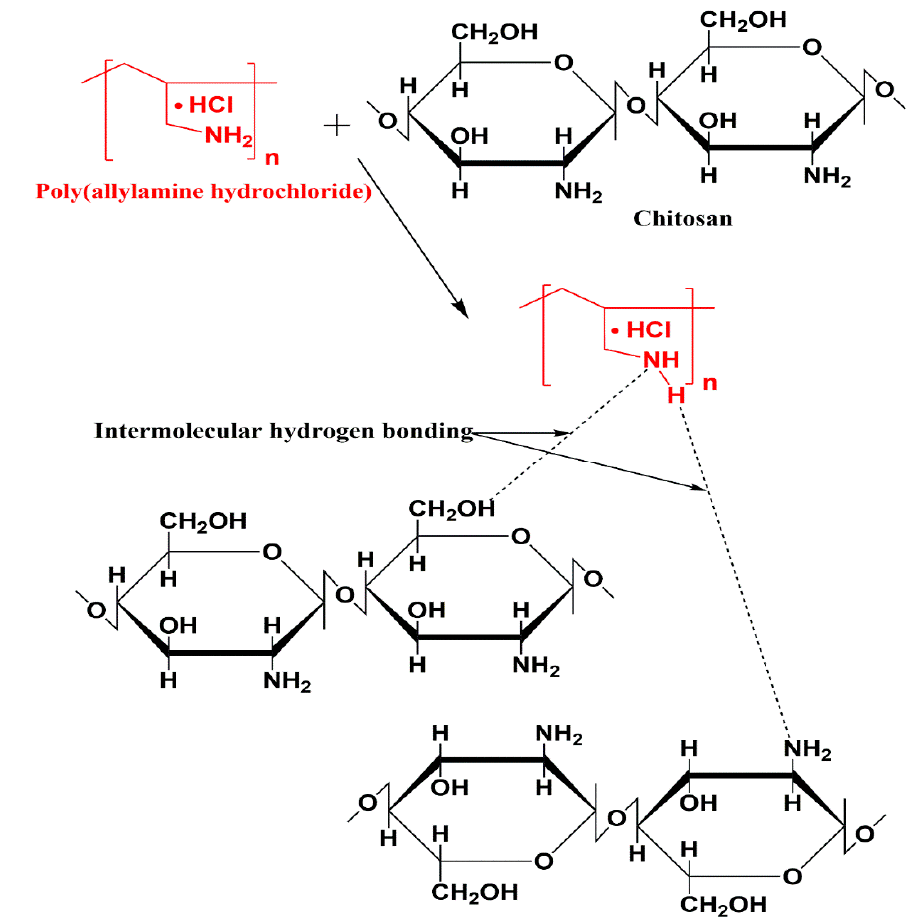
Figure 1. The proposed interactions between the CS and PAH in the prepared blend films.